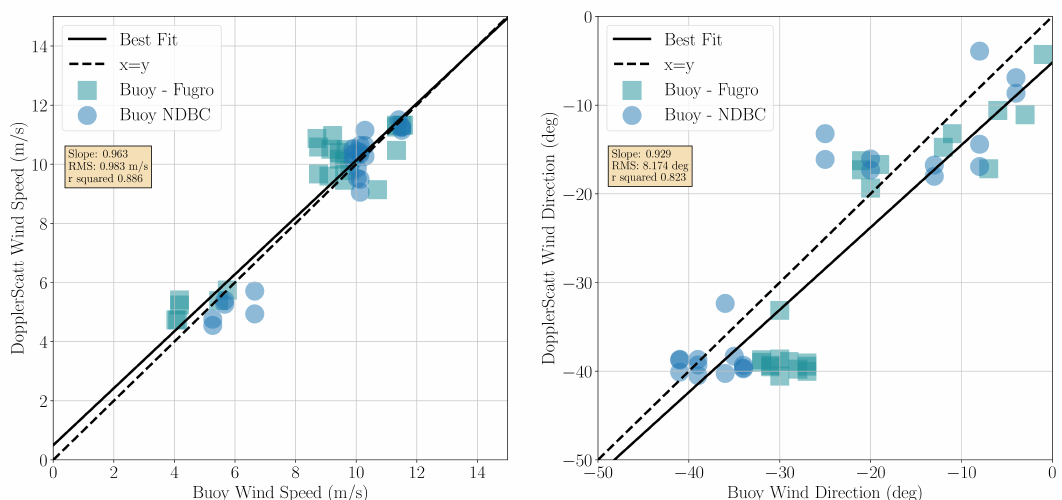
Figure 12. A colocated comparison of wind speeds ( left ) and wind directions ( right ) between buoy measurements and DopplerScatt measurements. Circles represent the comparison of colocated DopplerScatt measurements to NDBC buoy measurements. Squares represent the comparison of colocated DopplerScatt measurements to Fugro buoy